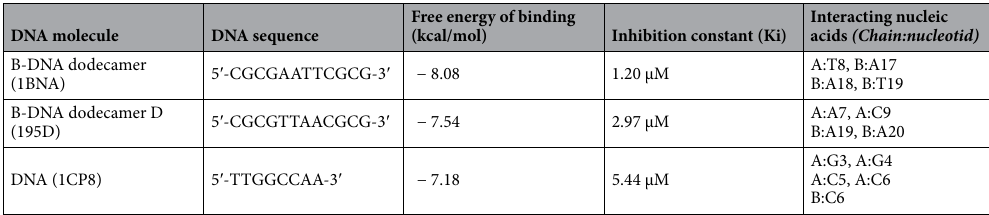
Table 4. The binding energy of AFM 1 with DNA molecules and interactions with nucleotides.